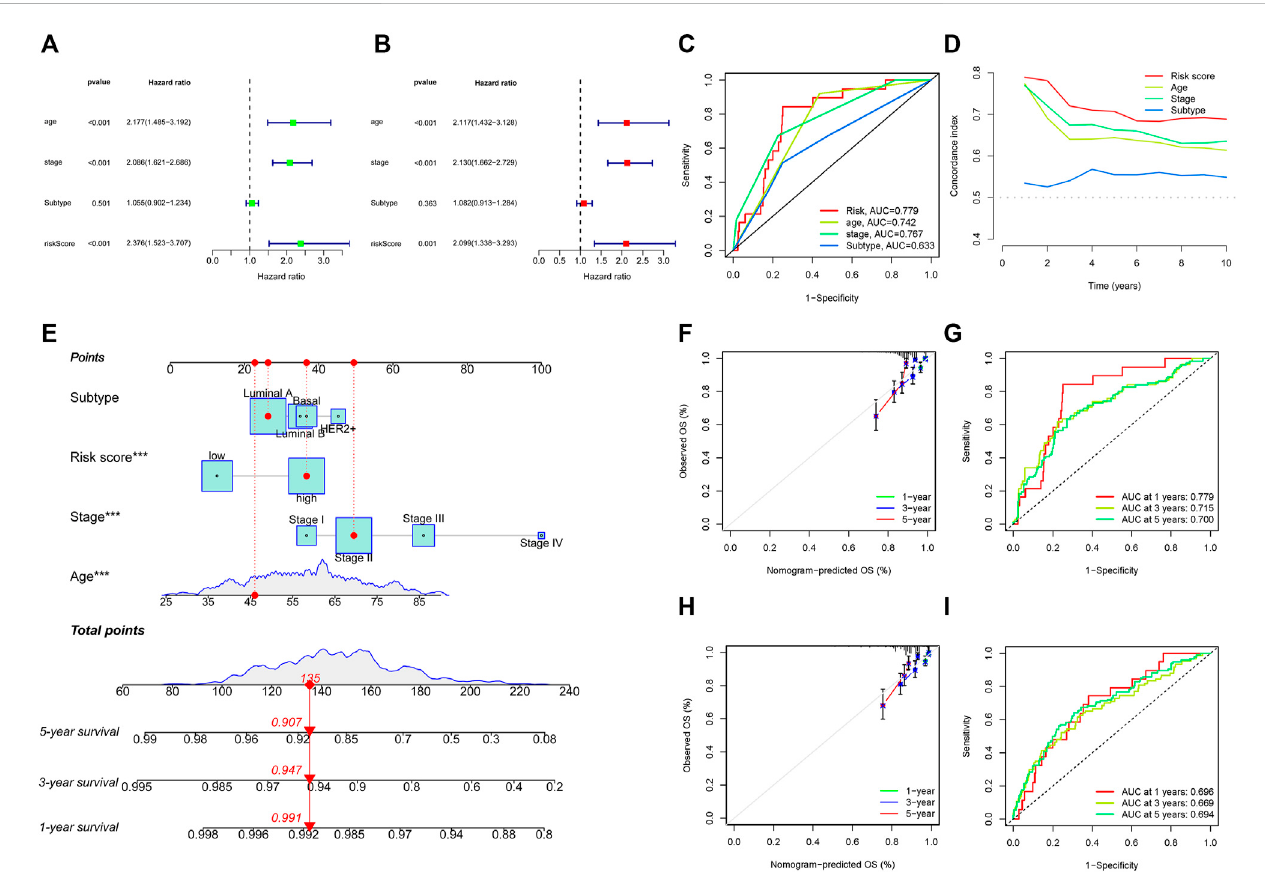
FIGURE 5 Identi fi cationof prognostic parameters inBC. (A) The univariateCox regression analysisintraining cohort. (B) The multivariate Coxregressionanalysisin training cohort. (C, D) ROC curves and C-index for the risk score, age, stage, and subtype in training cohort. (E) Construction of nomogram for survival predictionintrainingcohort. (F,I) CalibrationplotsandROCcurvesofthenomogramforpredictingtheprobabilityofOSat1-,3-,and5-yearsintraining (F,G) and validation (H, I) cohorts. ROC, receiver operating characteristic; BC, breast